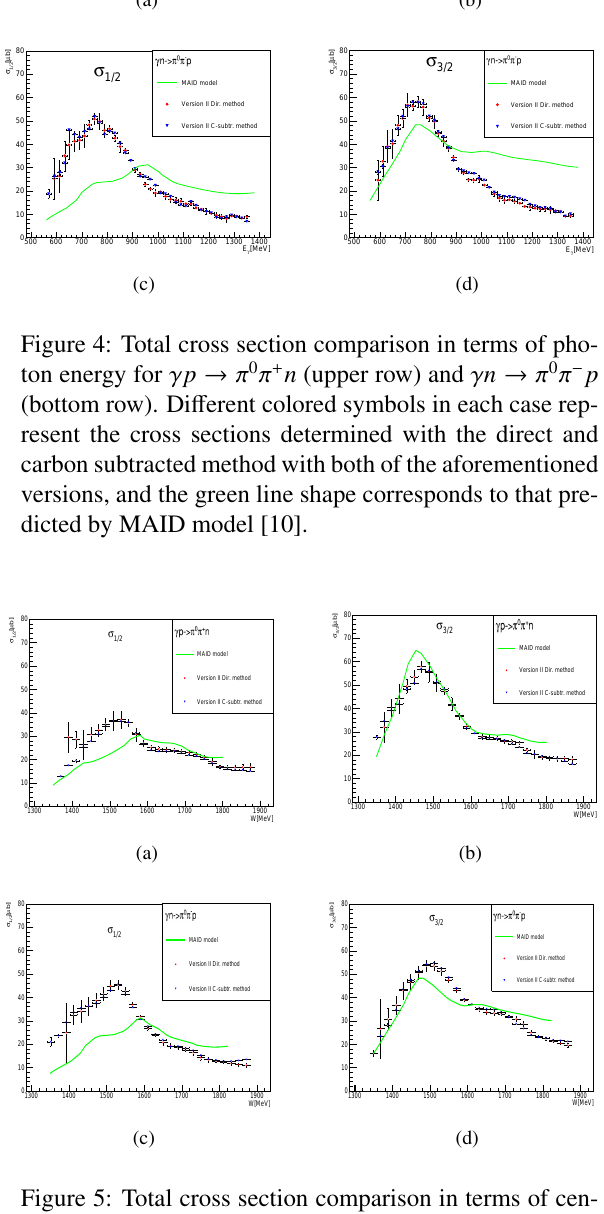
Figure 5: Total cross section comparison in terms of cen- ter of mass energy for γ p → π 0 π + n (upper row) and γ n → π 0 π − p (bottom row). Di ff erent colored symbols in each case represent the cross sections determined with the direct and carbon subtracted method with both of the aforementioned versions, and the green line shape corre- sponds to that predicted by MAID model